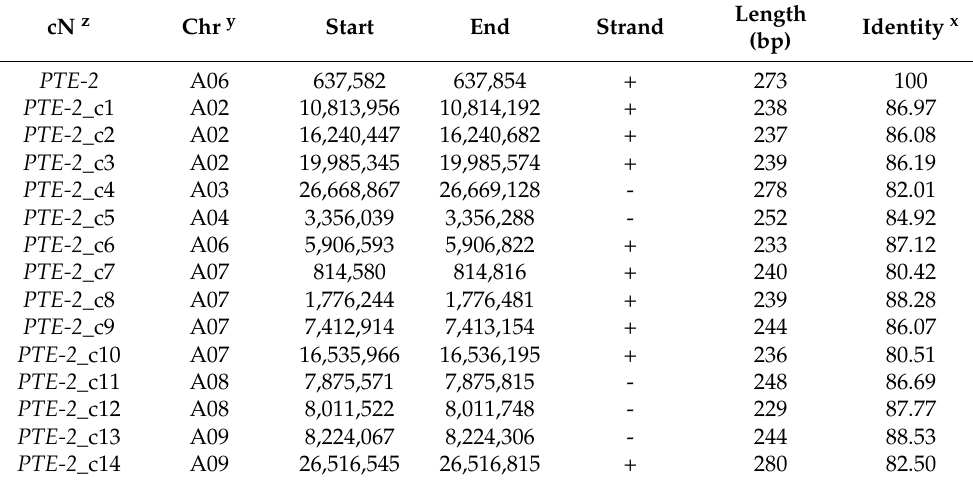
Table 2. PTE-2 copy elements at different loci in ‘CT001’